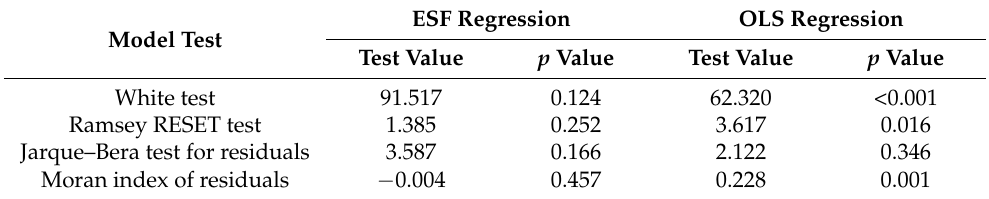
Table 10. Model test of OLS regression and ESF regression (ln(Cult_V) as the dependent